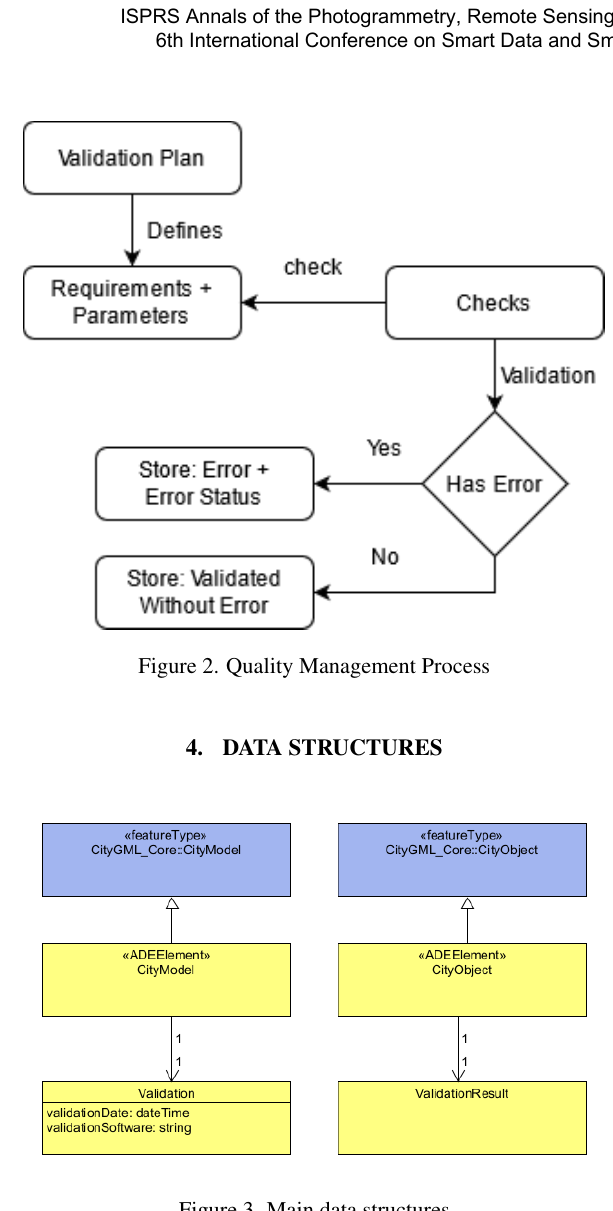
Figure 3. Main data